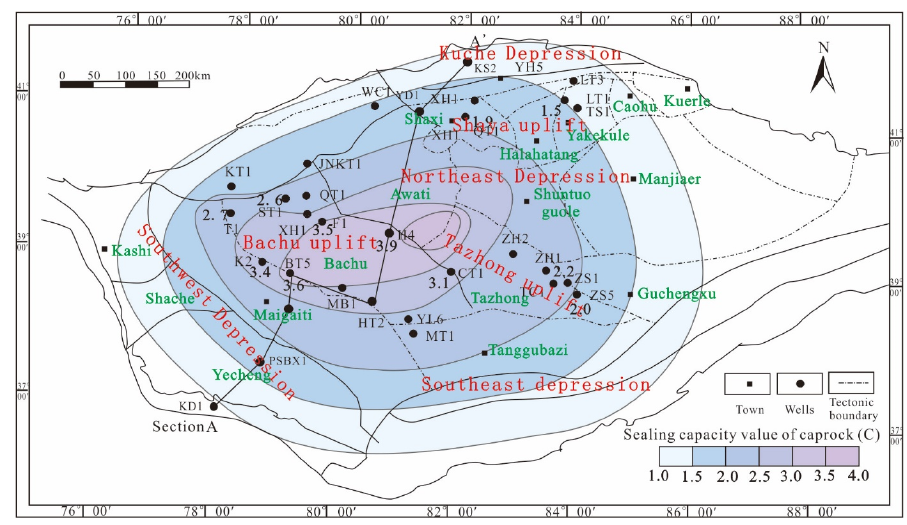
Figure 8. Contour map of sealing capacity value of Cambrian gypsum − salt caprock in the Tarim Basin. The trend of the isoline of caprock sealing capacity refers to the sedimentary facies map. Taking the west by south of the basin as the center, the sealing capacity gradually deteriorates to the surroundings. Table 6. Evaluation parameter weight value of sealing capacity of Cambrian gypsum − salt caprock.